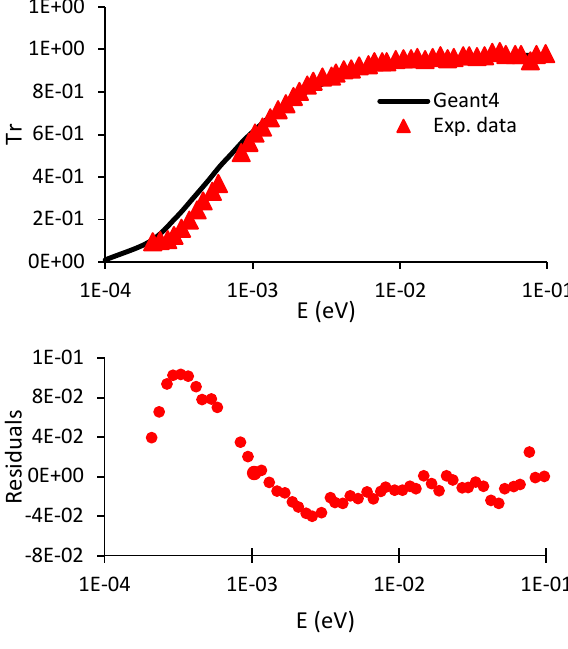
Fig. 6 . Quasi-specular reflection of CN with incident angle of 3°.